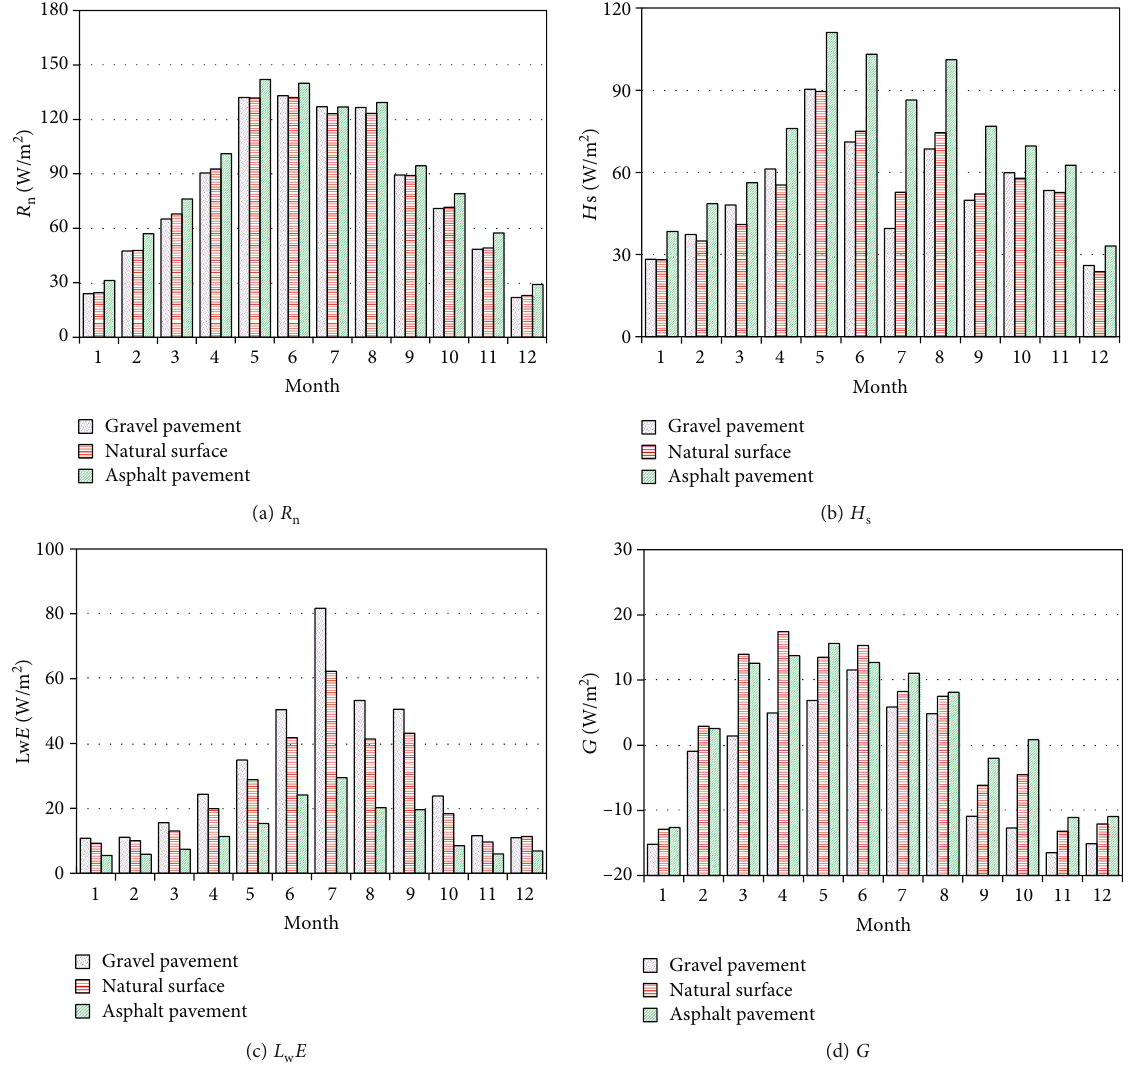
Figure 3: Monthly average of surface energy components at di ff erent underlying surfaces.